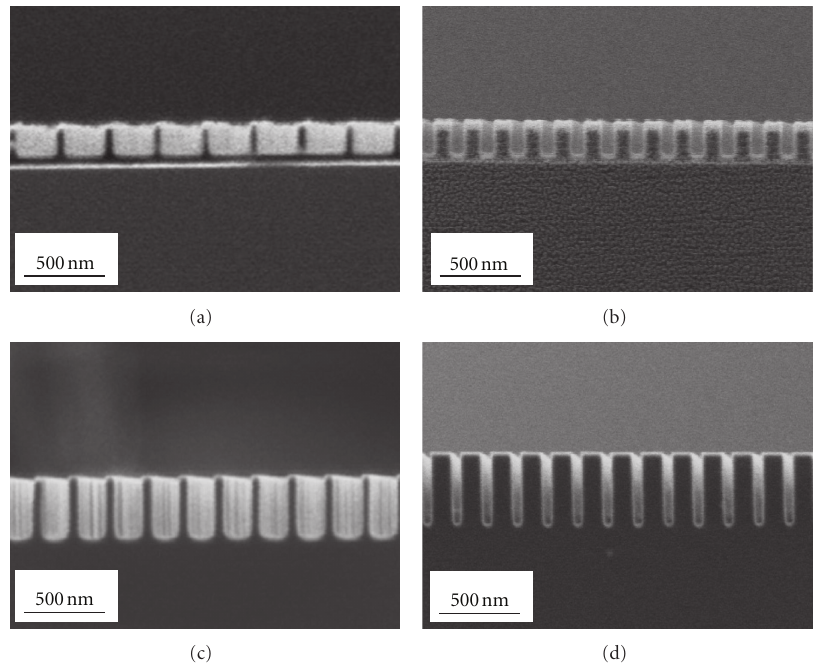
Figure 11: Cross-sectional SEM image: (a) 80nm lines and 160nm spaces was formed on a silicon substrate by UV nanoimprinting under atmospheric pressure, (b) 100 nm lines and 100 spaces was formed on a silicon substrate by UV nanoimprinting under atmospheric pressure, (c) 80 nm lines and 160nm spaces was fabricated by a deep RIE system after UV nanoimprinting, (d) 100 nm lines and 100 nm spaces was fabricated by a deep RIE system after UV